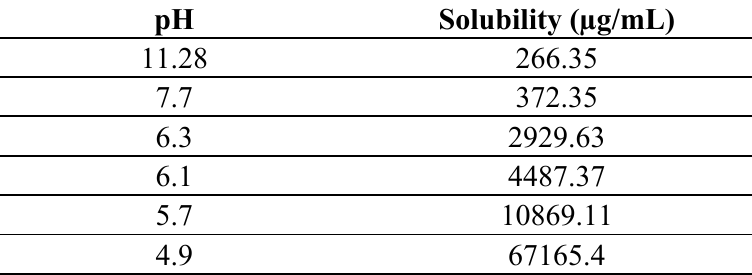
Table 2. Theoretical calculations of pH solubility profile using (Equation 1). [Bs] = 266.35µg/mL and pKa =7.3.